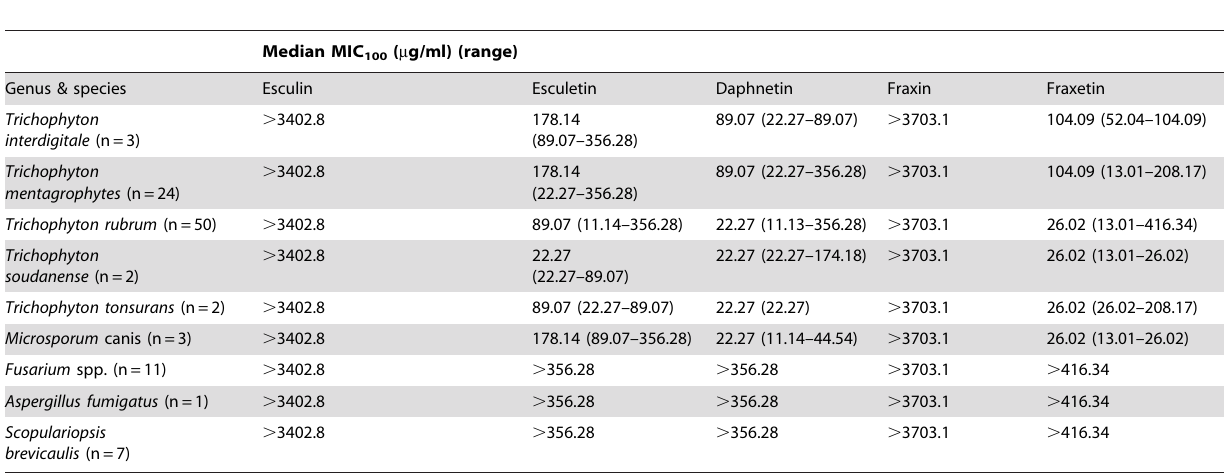
Table 1. Minimal Inhibitory Concentration (MIC) of coumarin glycones and aglycones against fungi isolated from human superficial